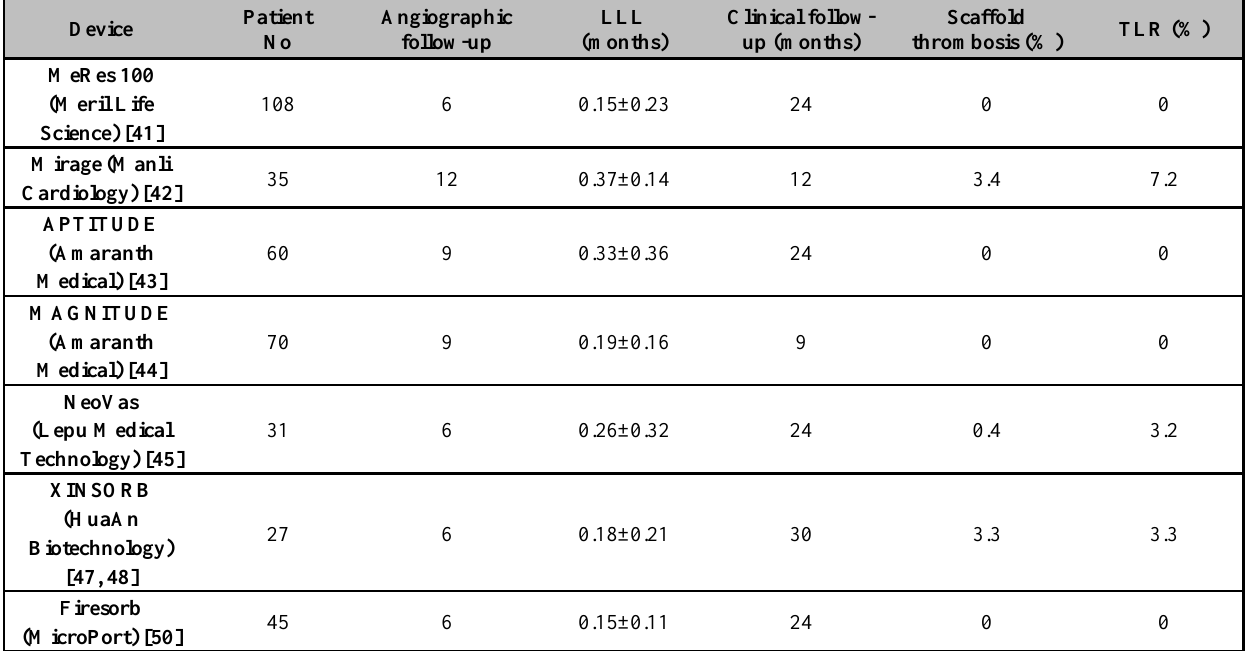
Table 4: Clinical trials of other bioresorbable